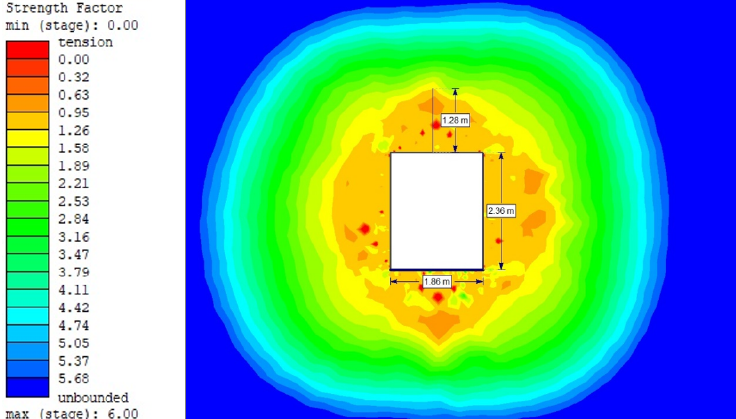
Figure 7. Strength Factor for Vernier excavation beam without bolting (Hoek–Brown criterion).